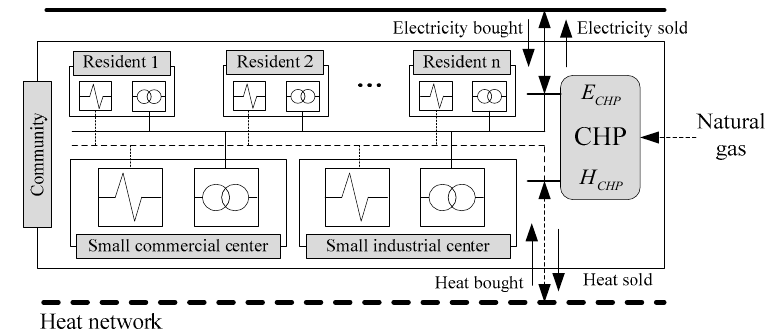
Figure 1. Typical network ‐ connected combined heat and power (CHP) system.